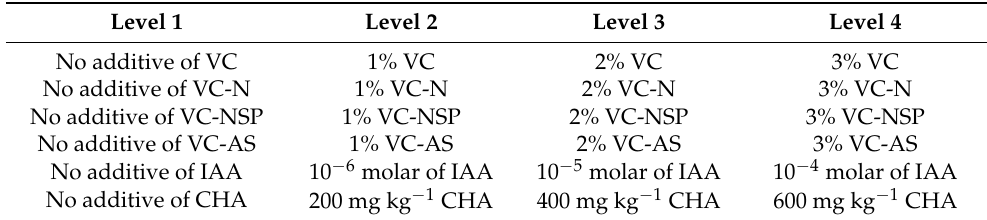
Table 2. Soil amendment composition and application level (1- VC without enrichment (VC); 2- VC